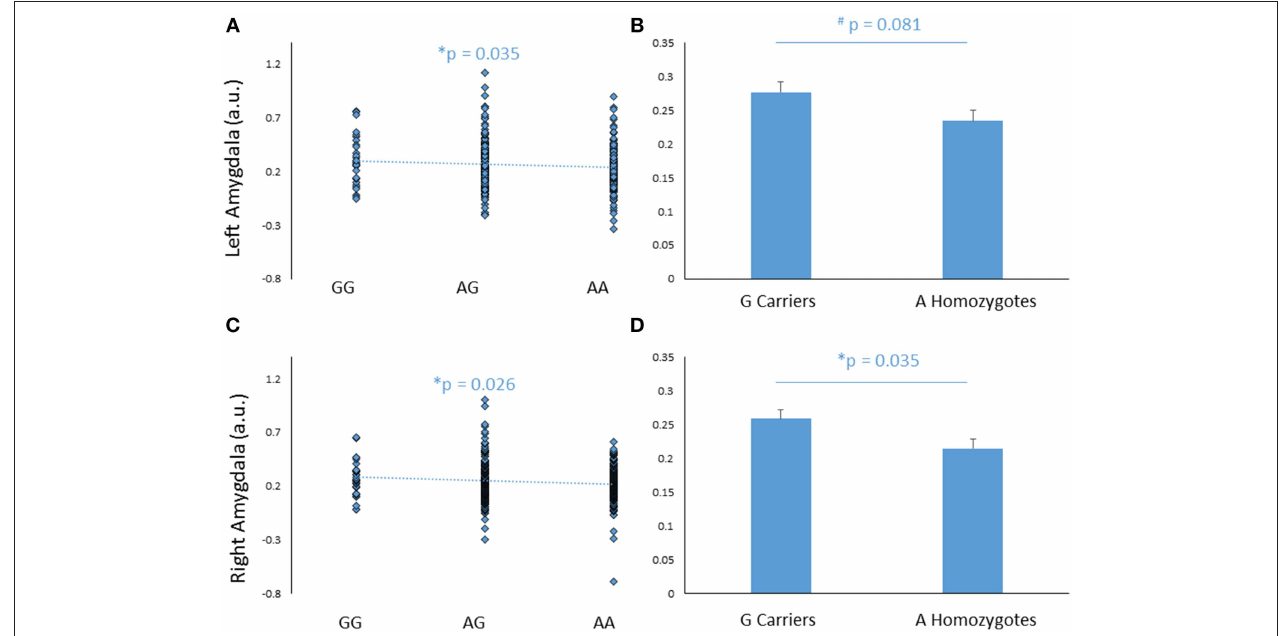
FIGURE 2 | Effects of FREM3 rs7676614 genotype on amygdala reactivity. Increasing number of A alleles was associated with decreased amygdala reactivity in the left (A) and right (C) hemisphere. In a G allele dominant model, A homozygotes showed a trend toward decreased amygdala reactivity in the left hemisphere (B) and significantly decreased amygdala reactivity than G carriers in the right hemisphere (D) . Error bars represent standard error of the mean. * p < 0 . 05 , # p < 0 . 10 , a.u. = arbitrary units.